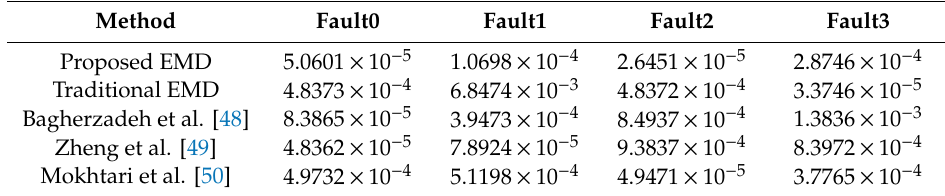
Table 6. Orthogonality index criterion.